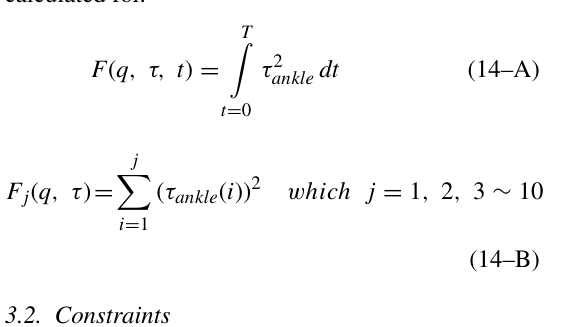
profiles of the joints for 10 time sequences.